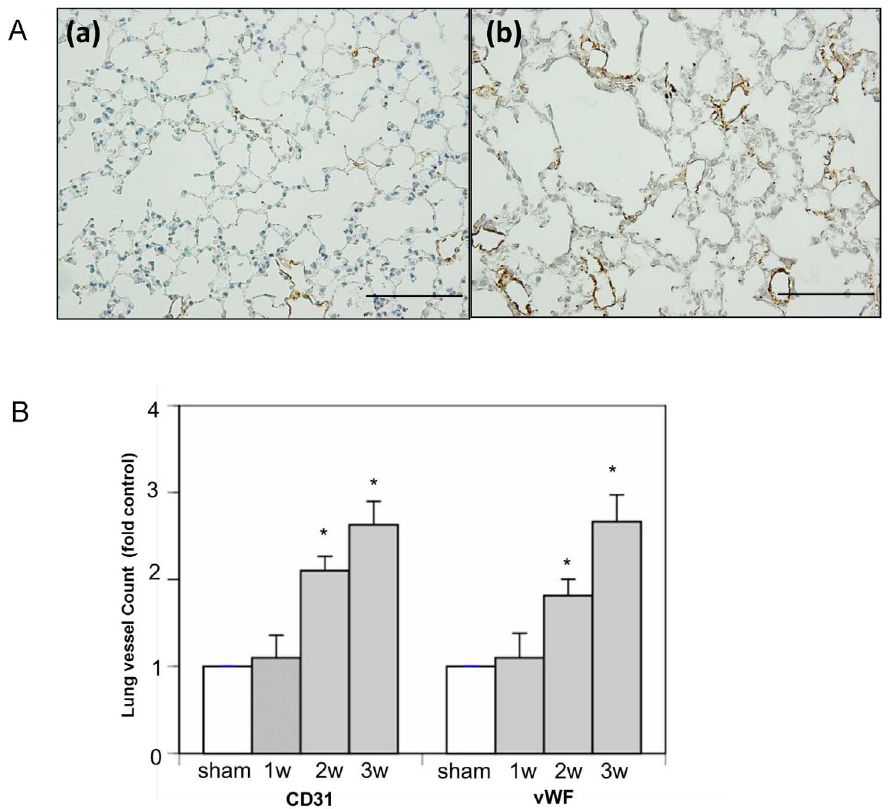
Figure 2. Immunohistochemical analysis of lung tissues in common bile duct ligated (CBDL) and sham-operated (control) mice. (A) Immunohistochemistry of von Willebrand factor (vWF)-stained lung section of sham and CBDL mice: (a) sham; (b) 3 weeks after CBDL. Scale bar =100 m m. (B) Graphical summary of lung microvessel counts by immunohistochemical analysis using CD31 and vWF antibodies in mice at 1–3 weeks after CBDL and in sham operated mice. *P , 0.05 (CBDL vs. sham).